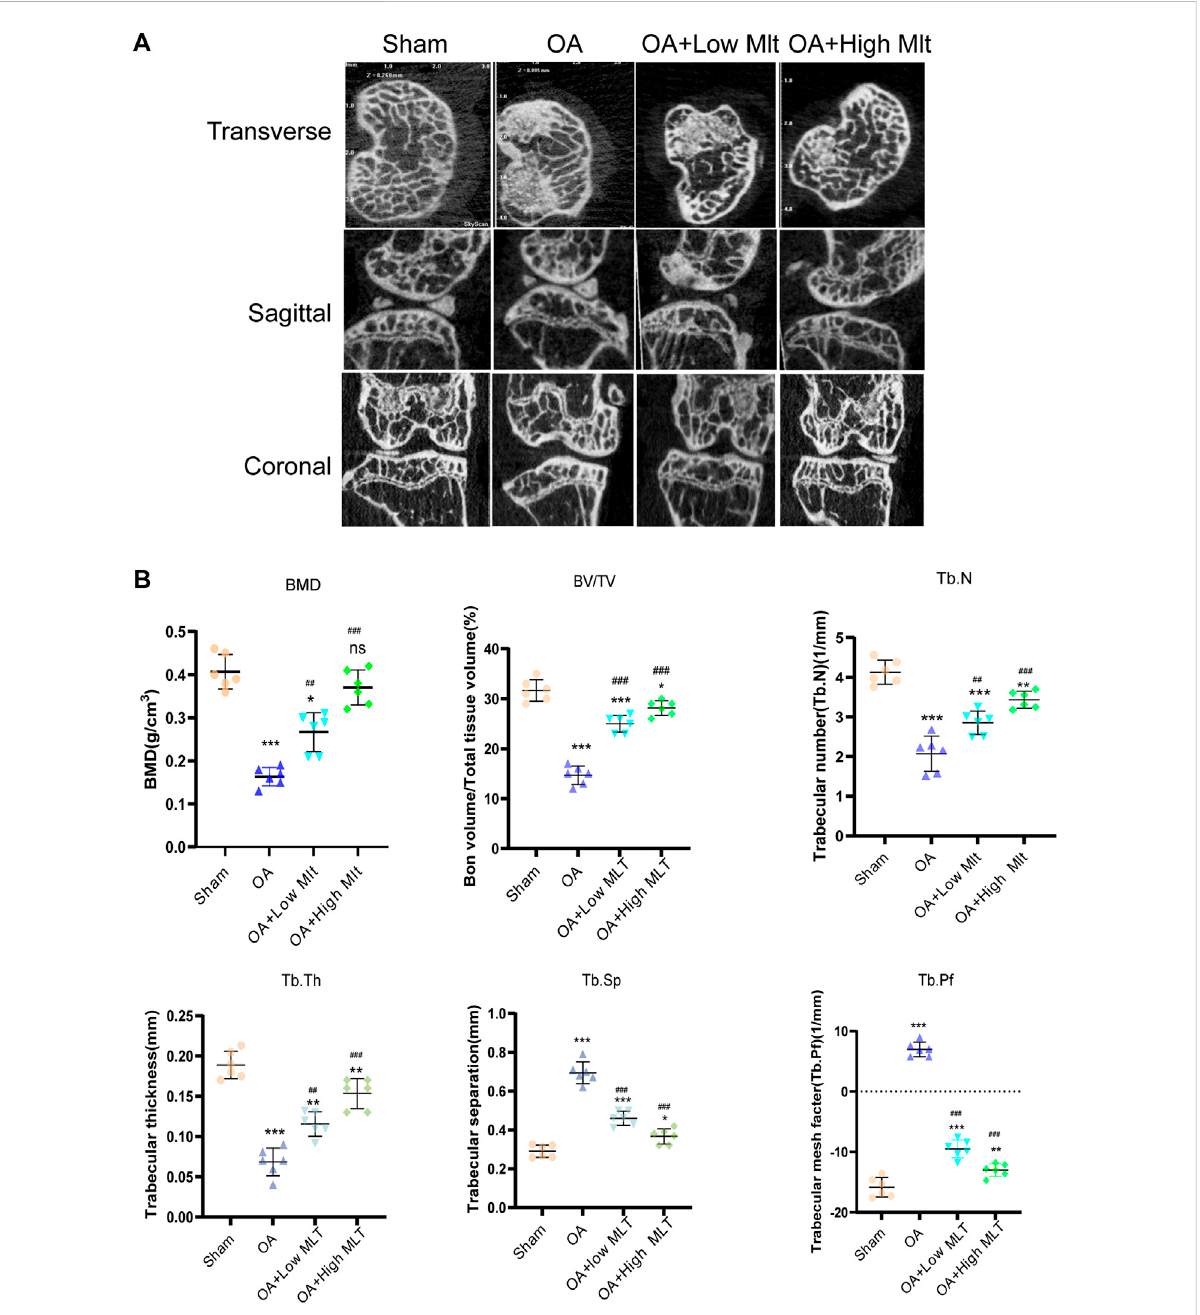
FIGURE 7 Preventive effect of melatonin on OA development in mice. (A,B) Analysis of bone destruction and knee joint bone histomorphometric parametersusingmicro-CTdata,Datawereshownasmean±standarddeviationandanalyzedusingone-wayANOVA(eachgroupn=6).* p <